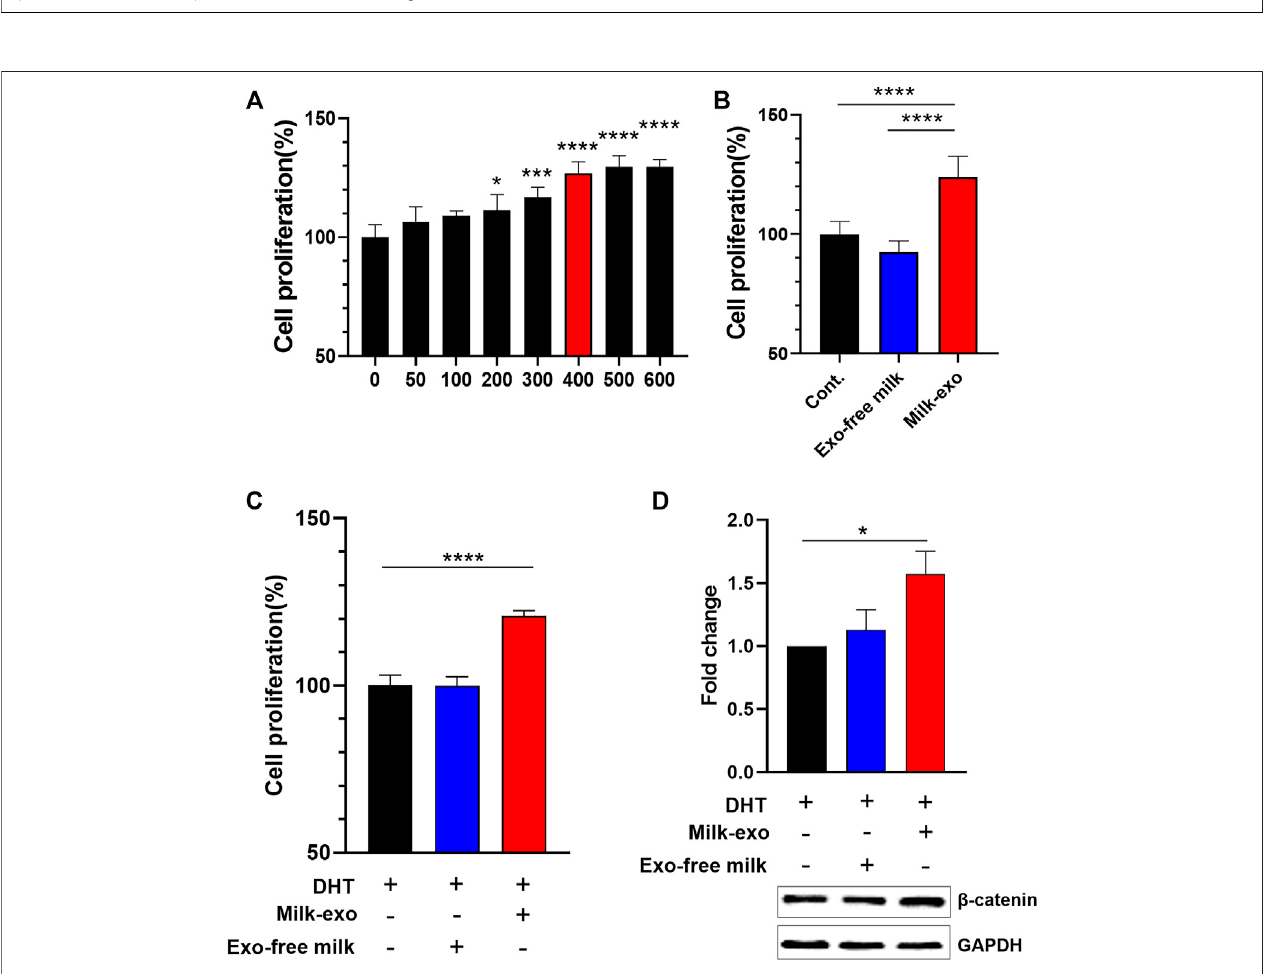
FIGURE3| EffectofMilk-exoon invitro proliferationand β -cateninexpression. (A) ProliferationanalysisofDPcellsinresponsetovaryingconcentrationofMilk-exo for 24 h ( n = 6). (B) Proliferation analysis of DP cells treated with Milk-exo and Exo-free milk at a concentration of 400 μ g/ml for 24 h ( n = 6). (C) Analysis of DP cell proliferation pattern after dihydrotestosterone (DHT) treatment ( n = 6). (D) Western blots on β -catenin and GAPDH in DP cells after Milk-exo and Exo-free milk treatment for 24 h ( n = 3). All data are presented as mean ± SEM (* p < 0.05, *** p < 0.001, and **** p < 0.0001 versus control).